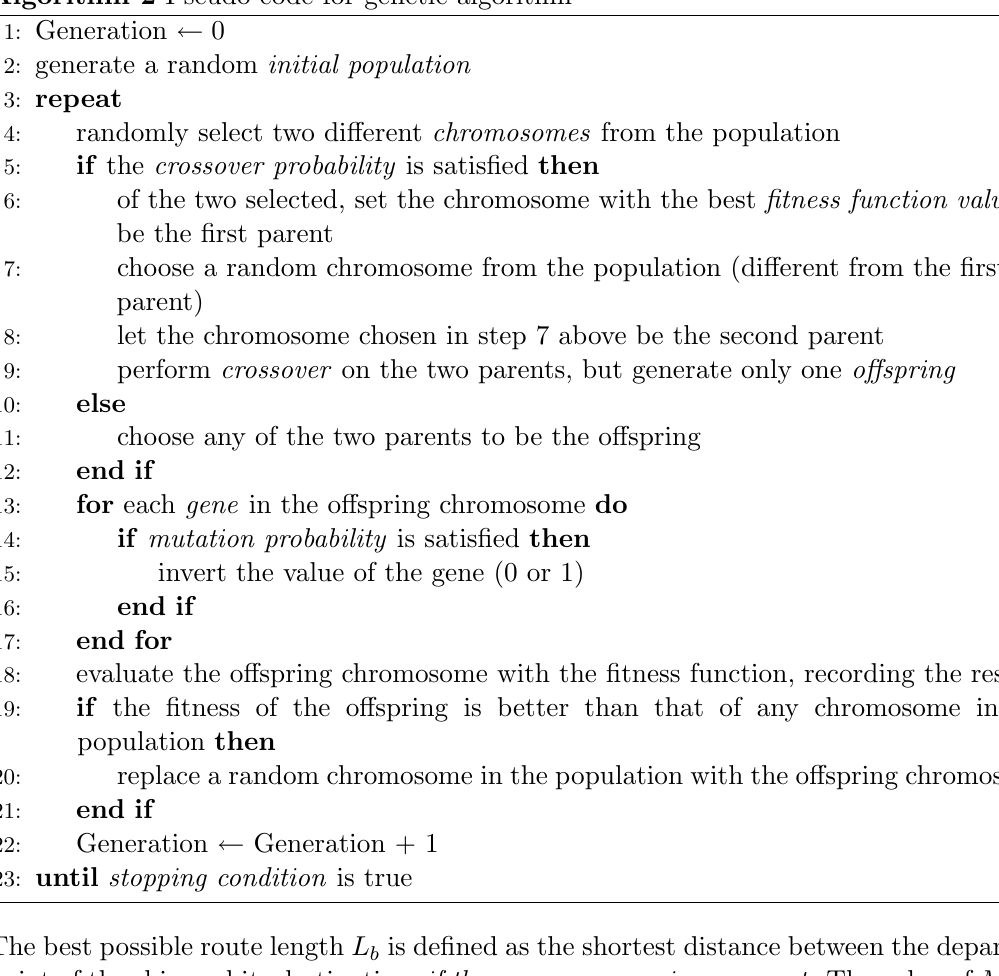
Algorithm 2 Pseudo code for genetic